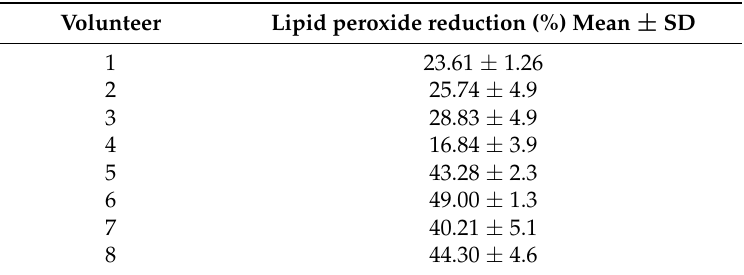
Table 6. Lipid peroxide reduction